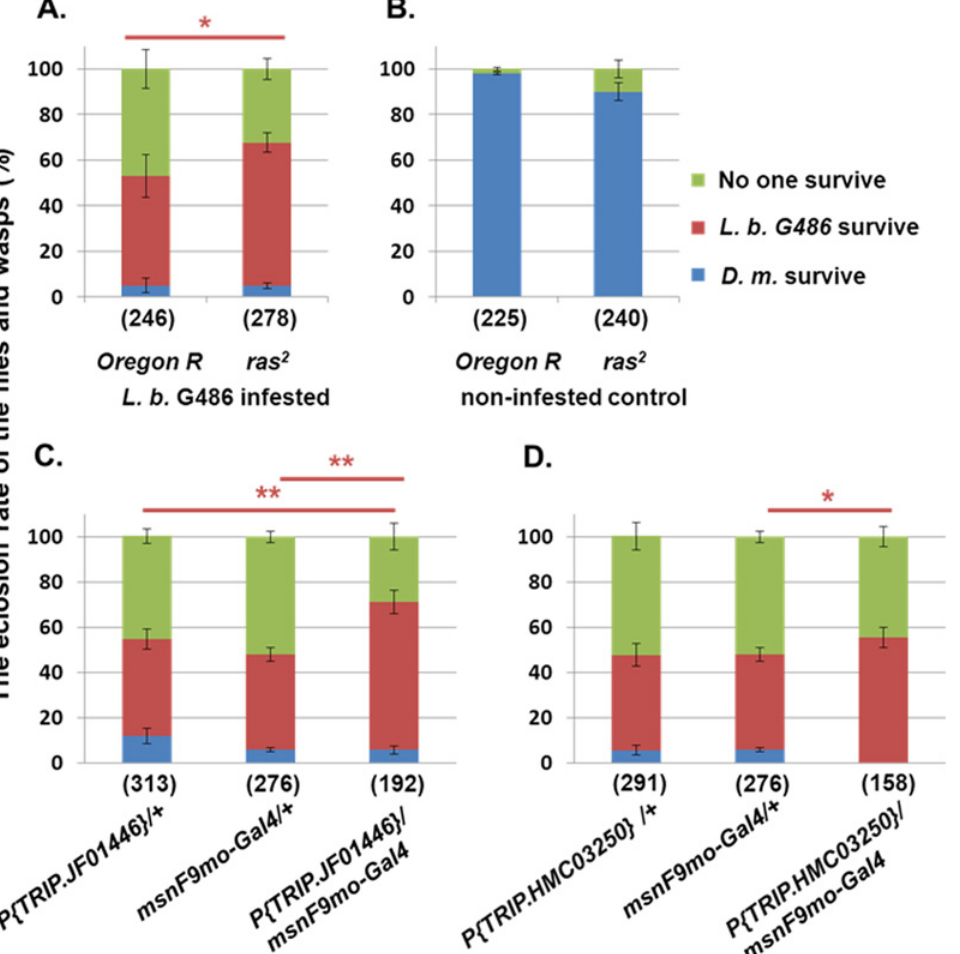
Fig 1. The eclosion of D . melanogaster versus L . boulardi G486 in ras 2 mutant and after RNAi silencing. (A) The eclosion of flies (blue) and wasps (brown) from the ras 2 mutant or from the Oregon-R after parasitization and from the (B) non-infested control. (C, D) Number of hatching flies from the L . boulardi G486 infested progenies ( msnF9mo-Gal4 > P{TRIP . JF01446} and msnF9mo-Gal4 > P{TRIP . HMC03250} attP2} ) and parental lines ( P{TRIP . JF01446}/ + , P{TRIP > HMC03250/+ and msnF9mo/Gal4/+ ). The numbers in parenthesis indicate the number of the examined D . melanogaster pupae. The error bars indicate the standard error of the mean. * p < 0.05, ** p < 0.01.